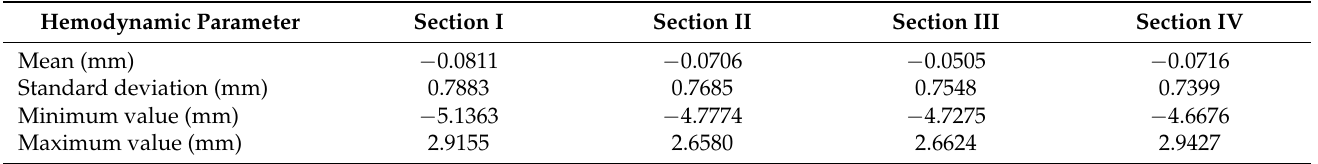
Figure A2. ( A ) The local differences of the respiratory self-gated and non-gated segmentations in a representative volunteer. The differences were calculated by measuring the Euclidean distance between each triangle of the self-gated surface mesh to the nearest triangle of the non-gated mesh along the normal direction of the first one. The region where the aorta was segmented from the left ventricle showed more significant differences between the segmentations, with and without self-gating. ( B ) A histogram of the local differences calculated at each section for all volunteers. The bar plots show the fraction of differences calculated in each section and classified by its distance in millimeters. The local differences obtained between ± 1.0 mm were 87.61% in section I, 88.27% in section II, 88.66% in section III, and 89.11% in section IV. Table A2. The mean values of the local differences between the respiratory self-gated and non-gated segmentations, computed at each section using the signed value